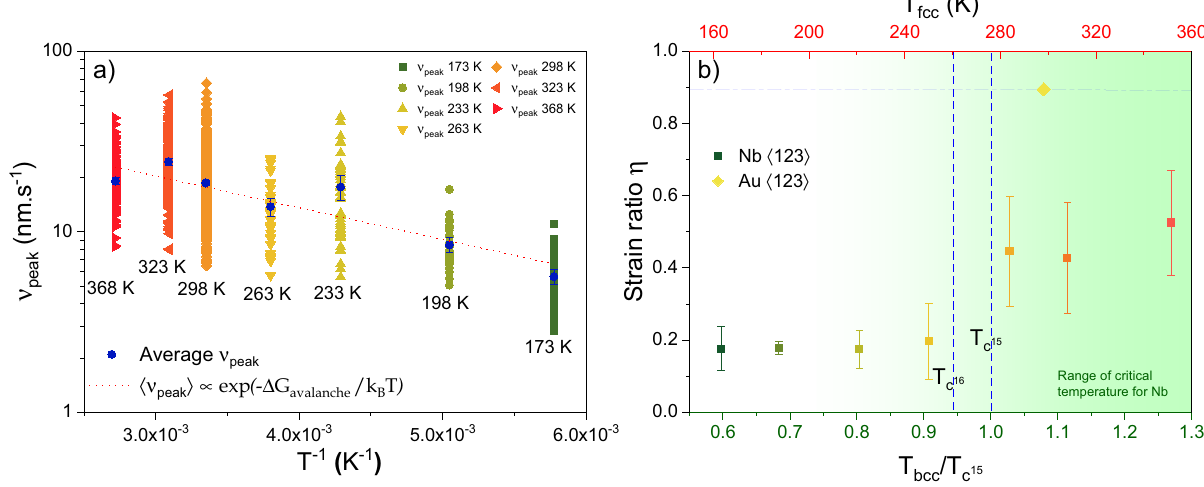
Fig. 3 Athermal and thermally activated components in microplastic fl ow of Nb. a Peak velocity of events for temperatures ranging between 173 and 368 K. An exponential fi t is applied to determine the effective barrier energy. The barrier energy is found to be an order of magnitude lower than the expected value for the fl ow stress in bcc crystals. b Temperature-dependent strain ratio with indicated literature values of T c for Nb 15,16 . The contribution of strain from avalanches increases around T c , eventually reaching a value more in line with single-slip oriented gold. The error bars correspond to the standard deviation for each